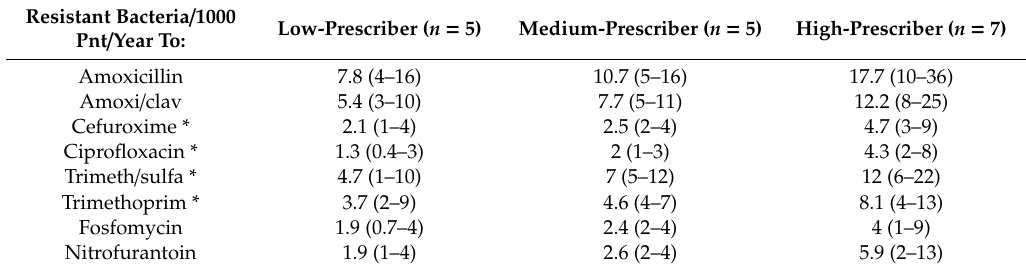
Table 4. Resistance of all cultured bacteria related to registered patients split per prescriber group. Resistant Bacteria /